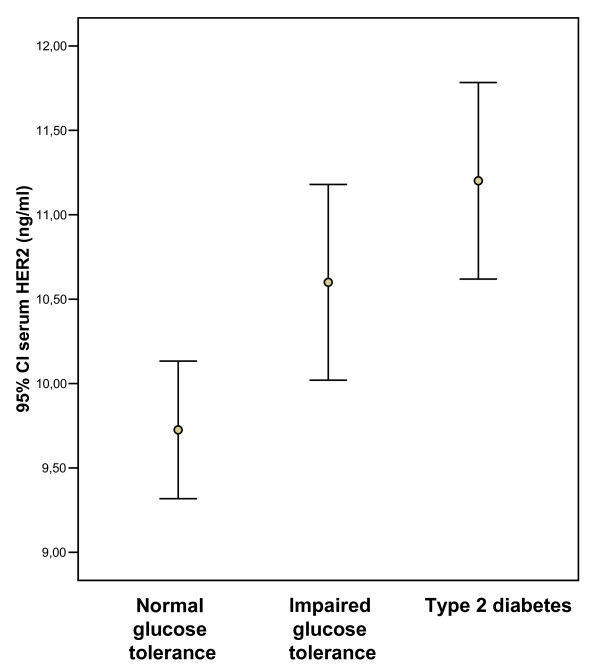
95% confidence interval for the mean of serum HER-2 according to glucose tolerance status in subjects from the Cohort 1 study.